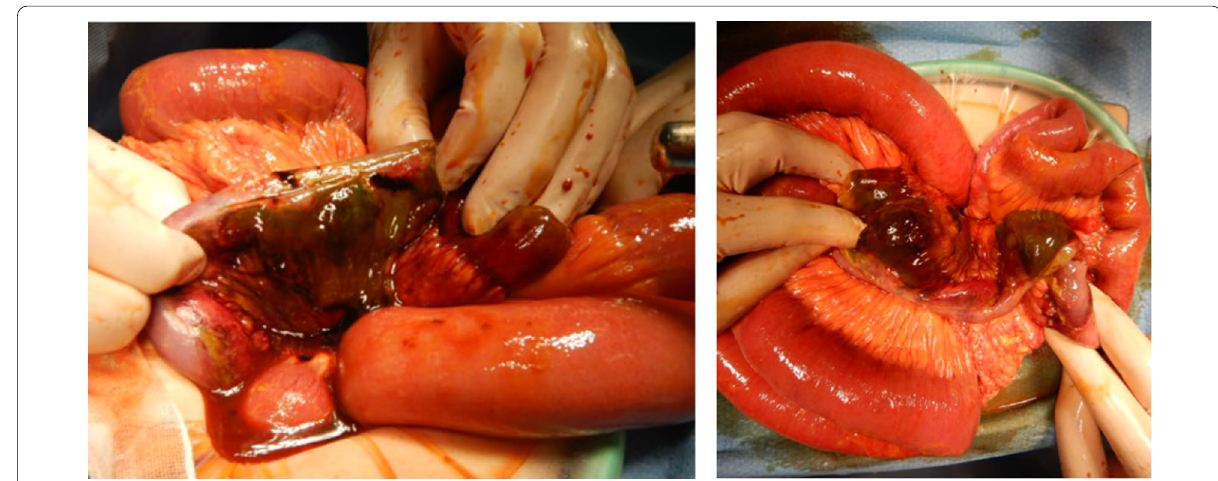
Fig. 3 Intraoperative findings: Multiple necrotic perforations were found 25 to 40 cm before the ileocecal valve, so partial resection of the ileum (about 70 cm) was performed